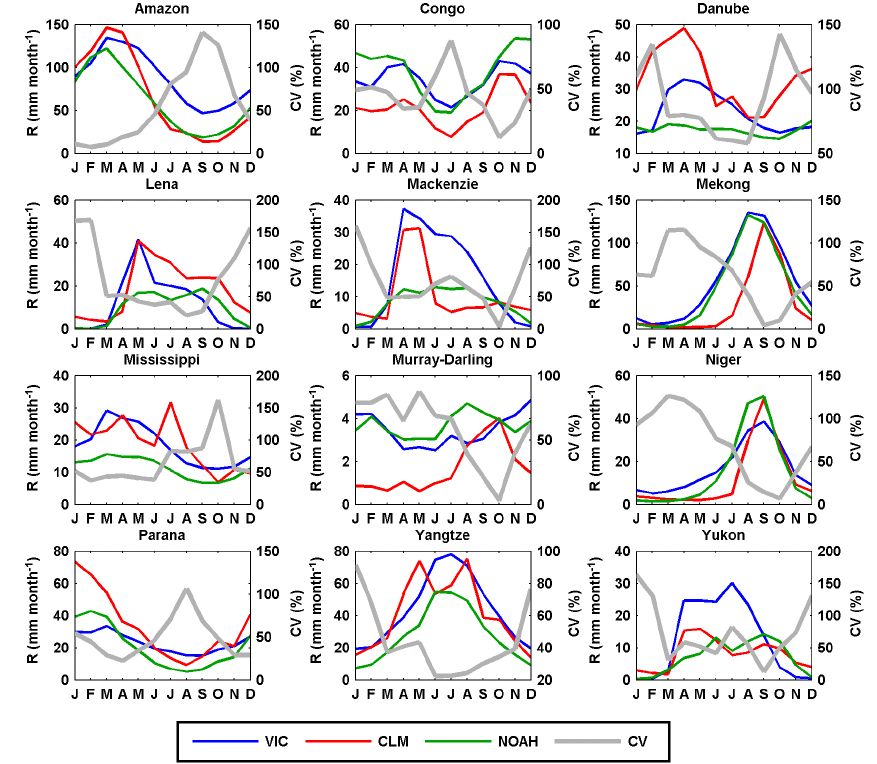
Figure 7. Seasonal cycles of runoff from different products over 12 representative large basins for